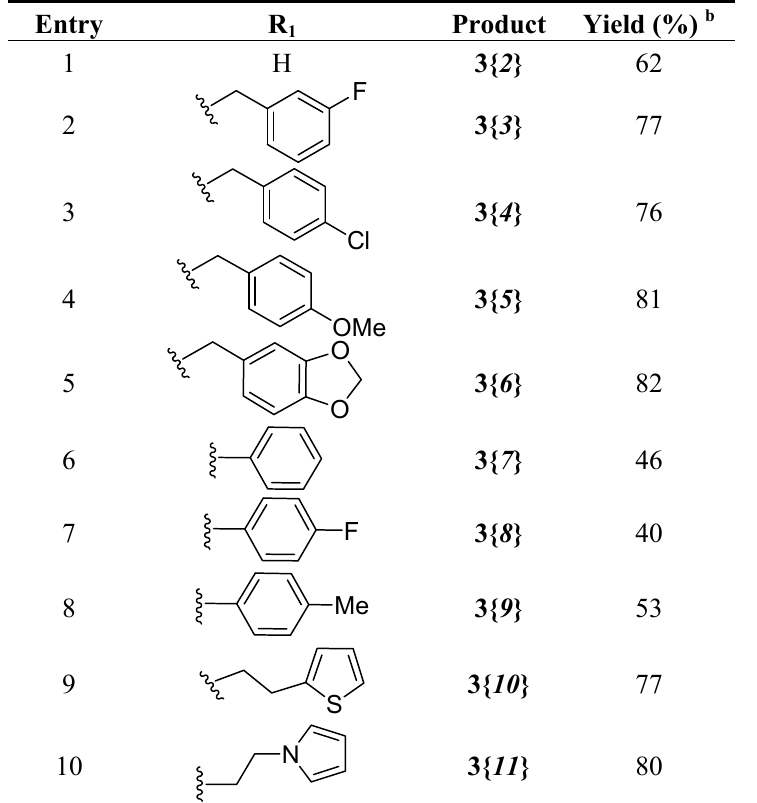
Table 2. Synthesis of N -substituted-3-benzylideneisoindolin-1-one a